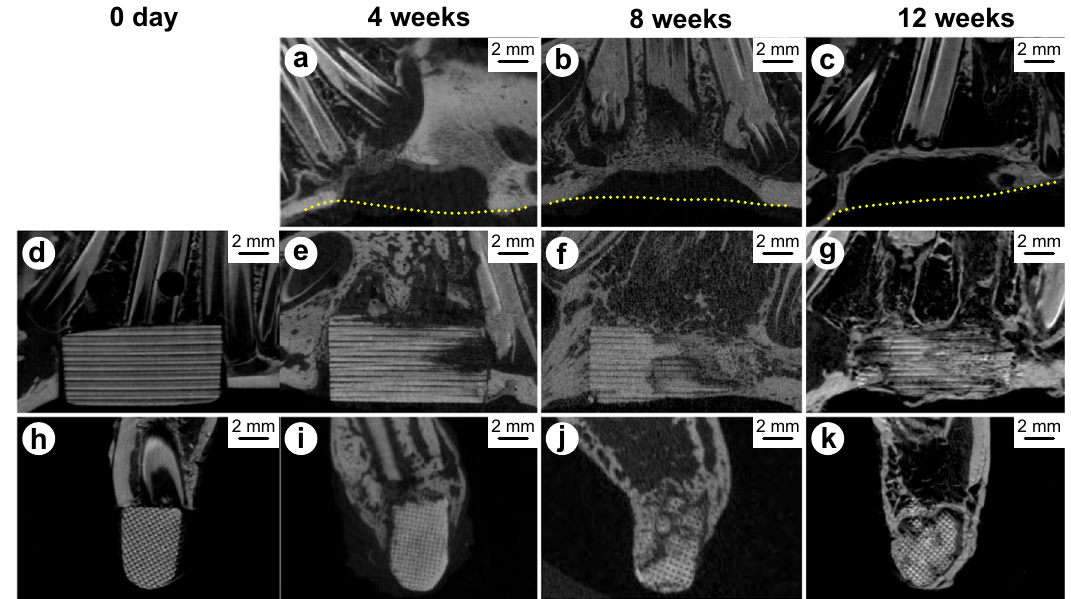
Fig. 6 μ -CT images. The empty defect ( a – c ) and CO 3 Ap HCB ( d – k ) at day 0 (immediately after implantation) and 4, 8, and 12 weeks after implantation. The dotted lines ( a – c ) show the removed mandibular border. Sagittal sections ( a – g ) and cross-sections ( h – k ) of the pores